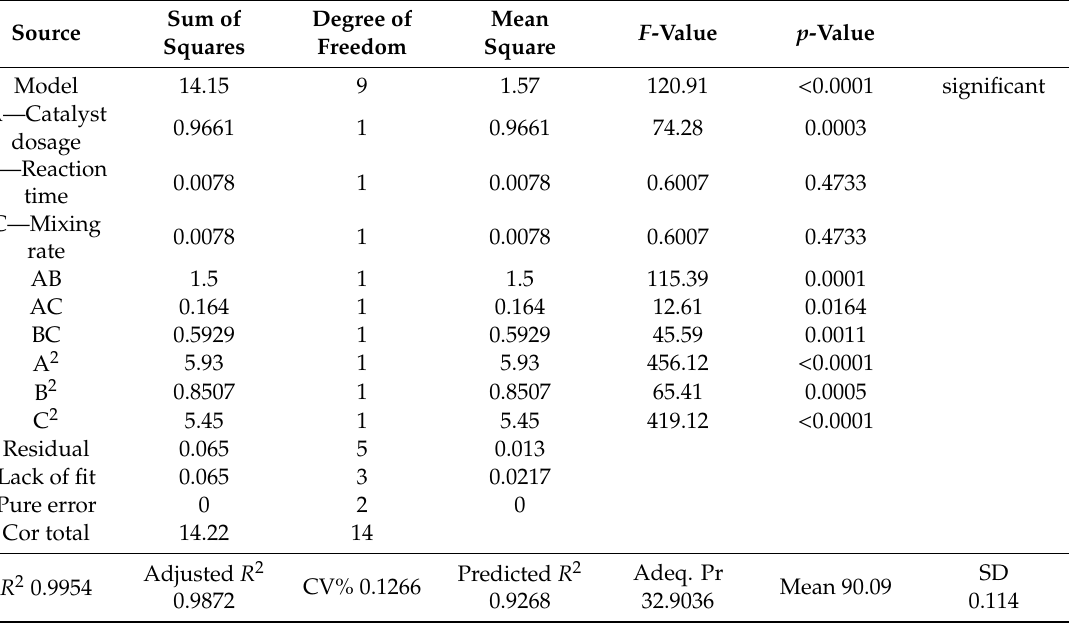
Table 7. ANOVA for COD removal by TiO 2 —quadratic model.